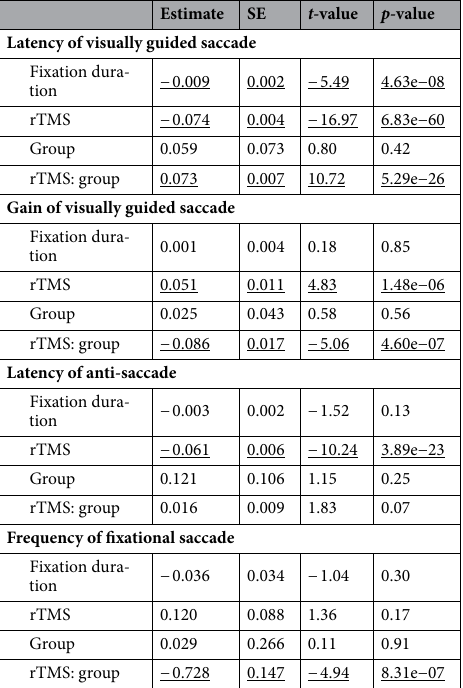
Table 3. Relationships between the post-rTMS improvement in the anti-saccade success rate and other saccade parameters. rTMS repetitive transcranial magnetic stimulation. Statistically significant coefficients of GLME models are underlined ( p <